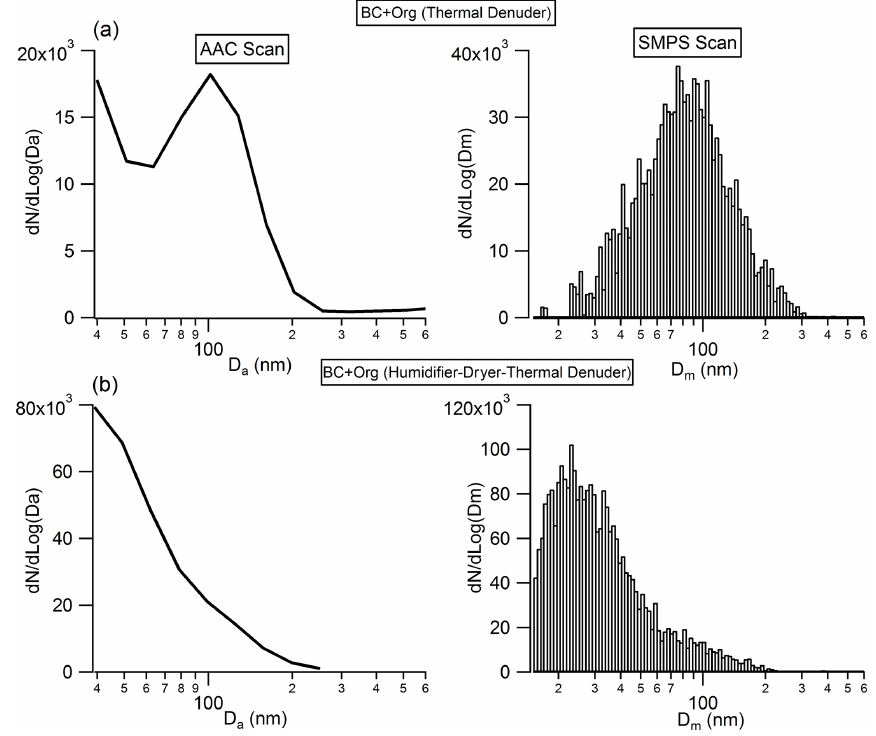
Figure 9. Number size distribution of the (a) organic-coated BC after passing through the thermal denuder to remove coatings and (b) organic- coated BC after experiencing the “humidity cycling” process and then passing through the thermal denuder to remove coatings.